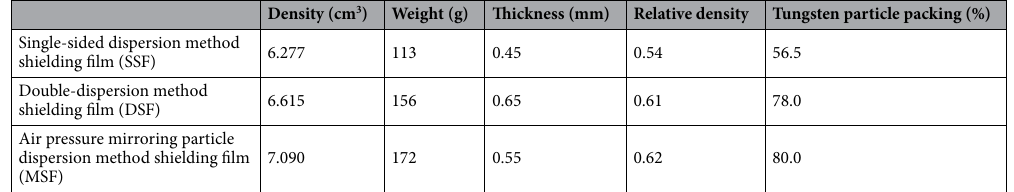
Table 1. Comparison of shielding films produced using the three different